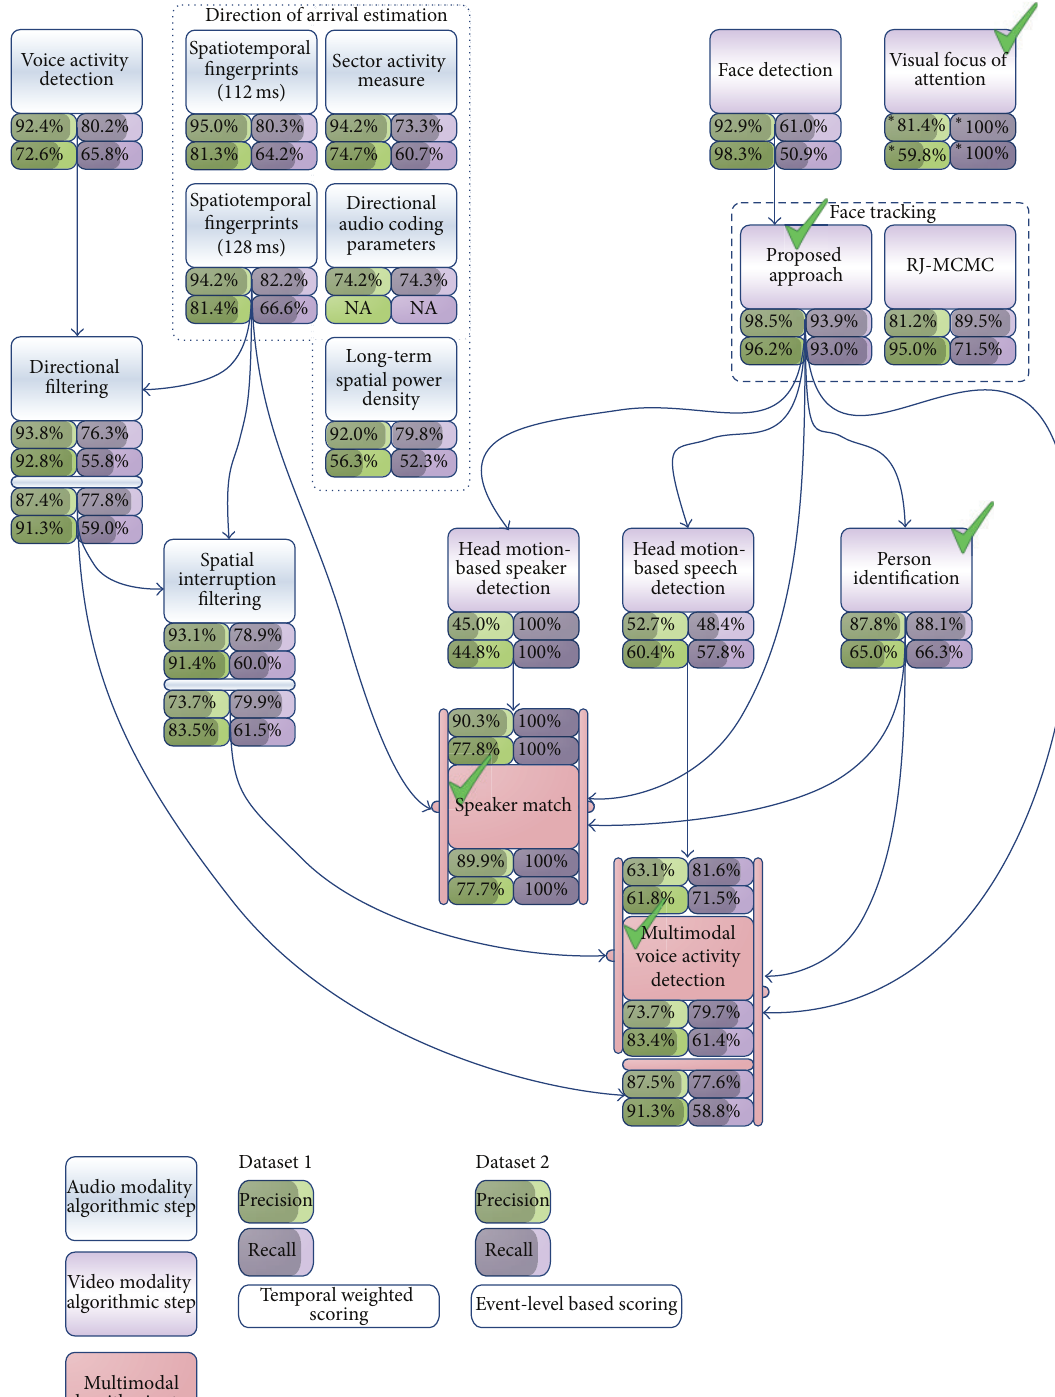
∗ Evaluations for visual focus of attention are based on subset of datasets ( 30 min for Dataset 1 , 5 min for Dataset 2) Figure 11: Evaluations at different steps of processing. Two different scorings of results are used: (a) temporal weighted scoring is used to better evaluate algorithms from the perspective of amount of time. (b) Event-level based scoring is used to better evaluate algorithms from the perspective of amount of discrete events. Upper blocks show basic precision/recall values; further blocks show achieved precision/recall values after each step of processing for the operating system’s point. The two lowest blocks (speaker match and multimodal voice activity detection) show the final achieved precision/recall values. The results from the blocks, marked with a tick, are propagated further to the TA2 system, while the results from other blocks are intermediate or